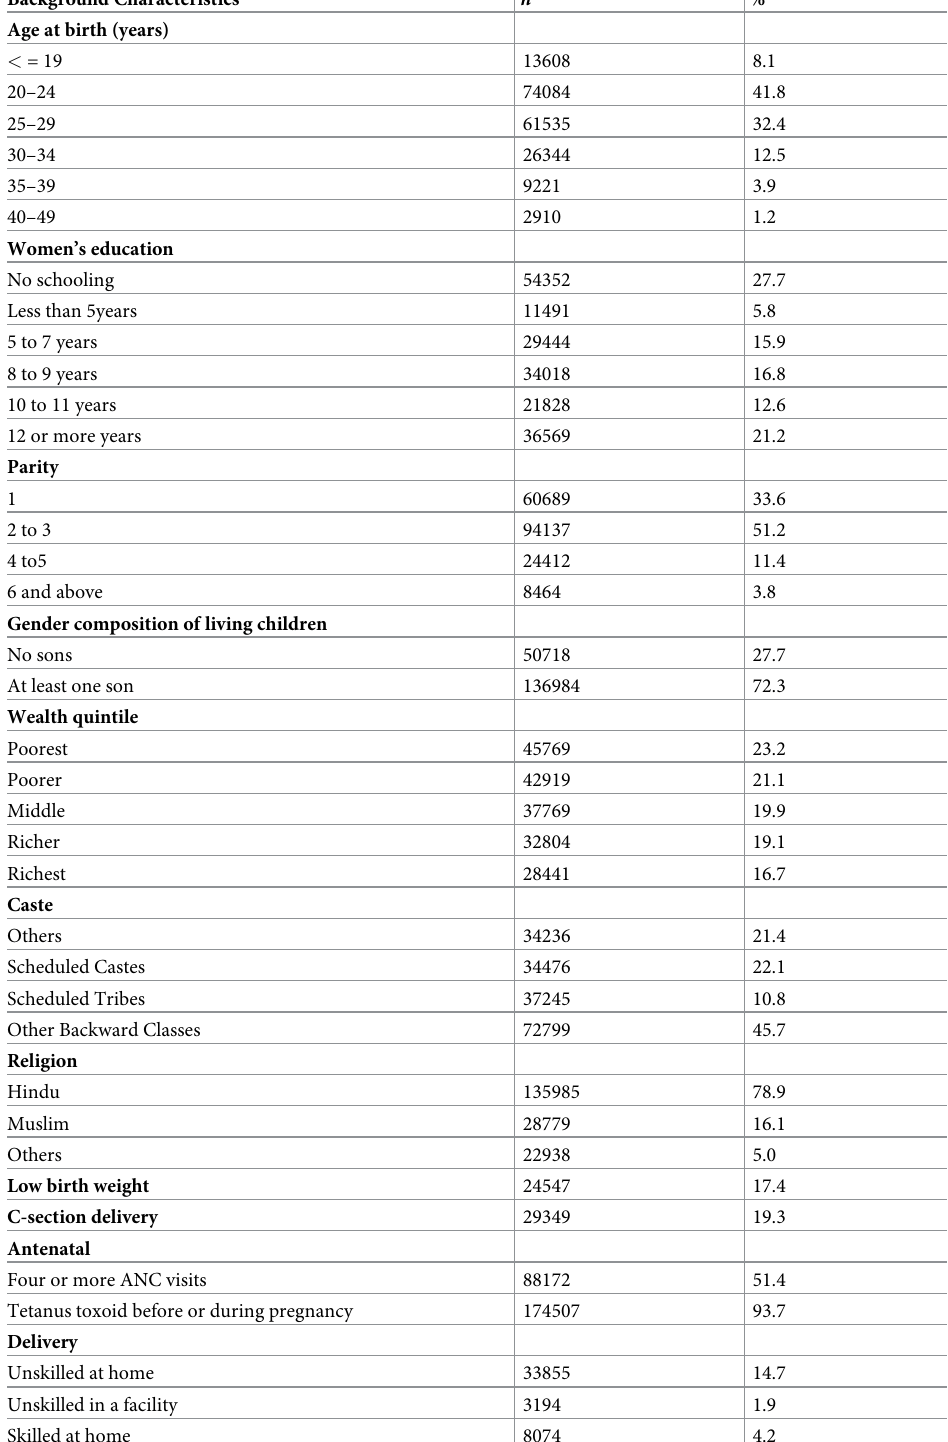
Table 1. Sample distribution of women with birth during five years preceding the survey, National Family Health Survey (NFHS) 2015–16, India. Background